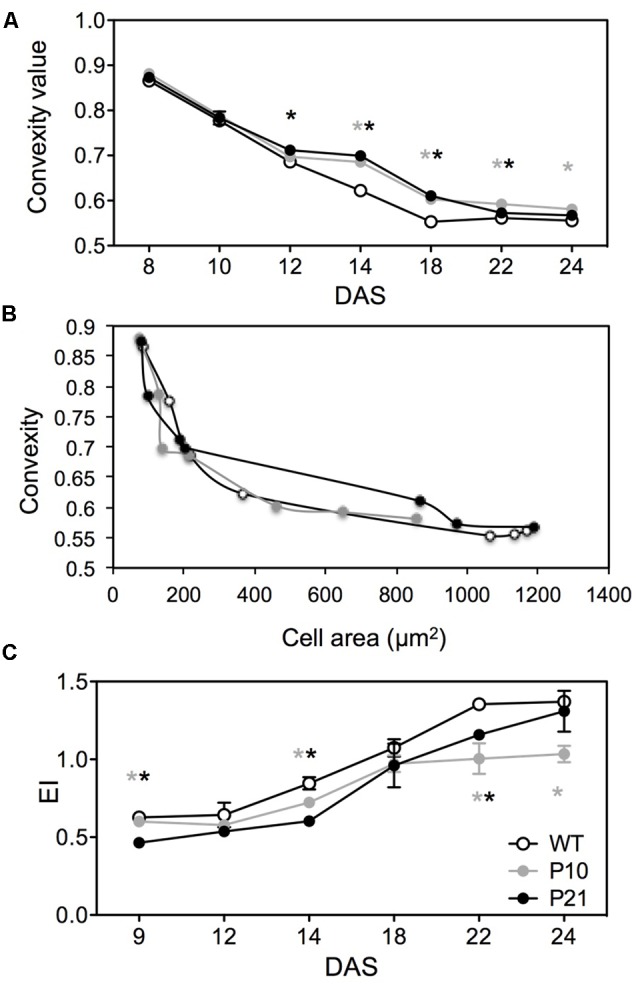
Cell shape and endoreduplication in wild type and PID overexpression lines. Comparison of pavement cell convexity in the abaxial epidermal layer at different time points between WT, P10 and P21 (A). Convexity and cell area correlation between different genotypes over time (B). Comparison of ploidy status (EI = 0∗2C+1∗4C+2∗8C+3∗16C) of various lines by means of number of endocycles undergone by nuclei (C). Error bar ± SE (t-test, P < 0.05). Gray and black asterisks represent significant difference of P10 and P21 compared to the WT, respectively.